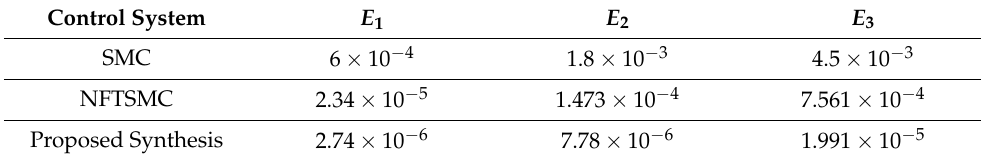
Table 3. RMSEs via three control